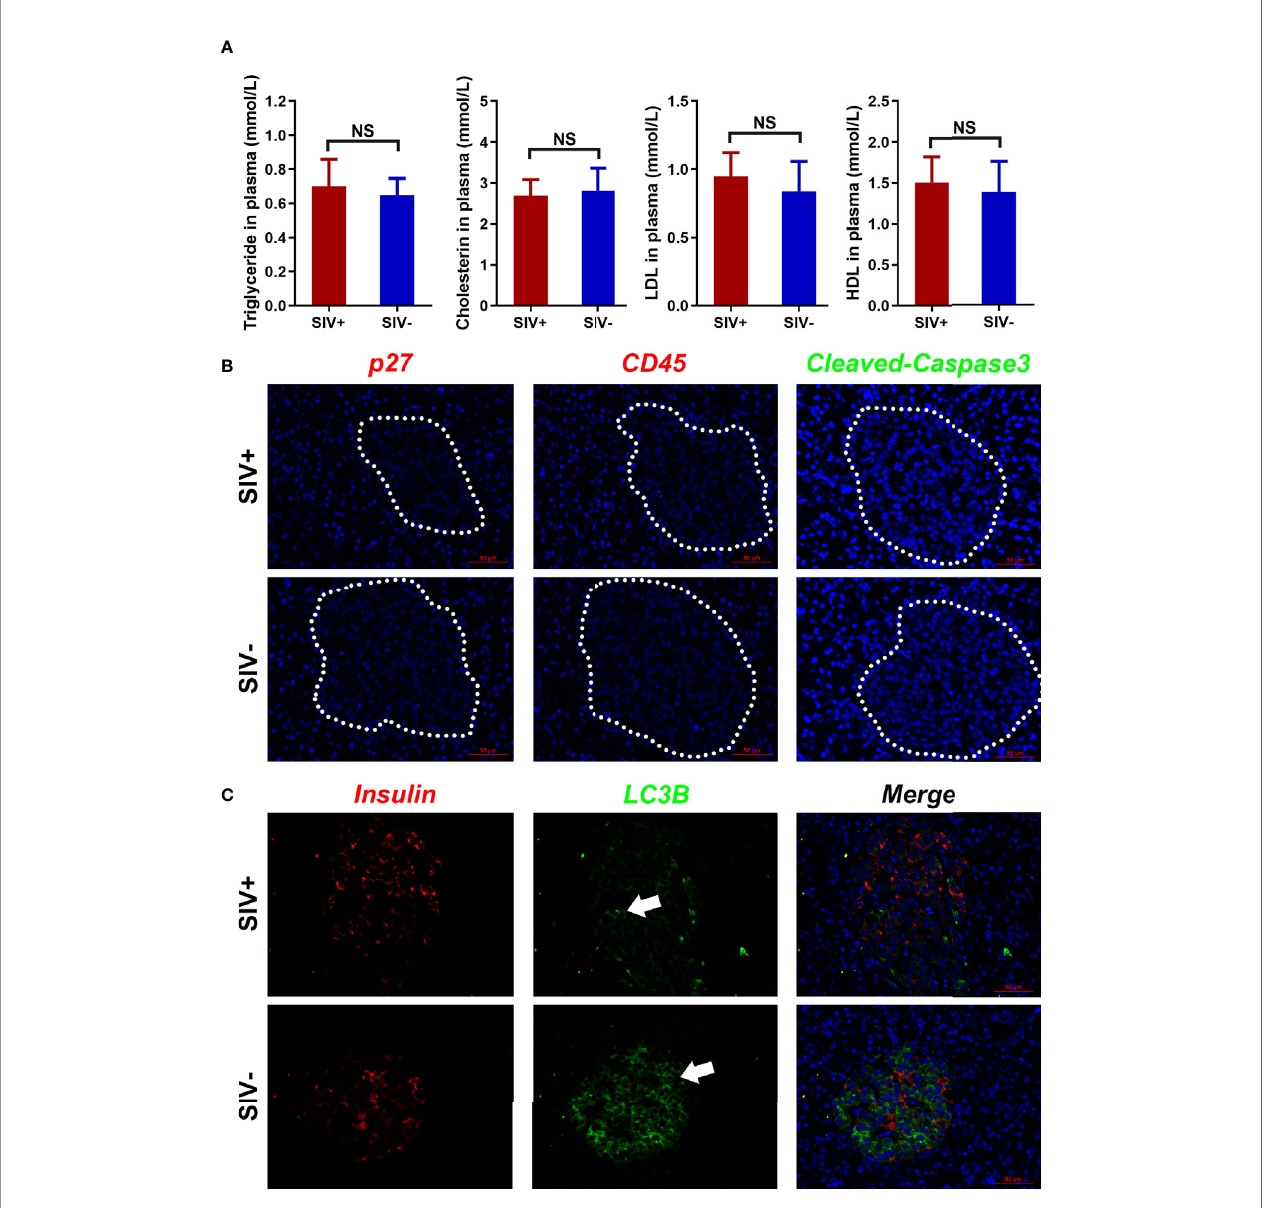
FIGURE 5 | Lipid metabolism and pathological changes in pancreatic islets. (A) Index analysis of lipid metabolism (triglycerides, cholesterin, LDL, and HDL); (B) Immunological staining of p27, CD45, and cleaved-caspase3 in pancreatic islets; (C) Immunological staining of insulin and LC3B in pancreatic islets. NS, no statistic signi fi